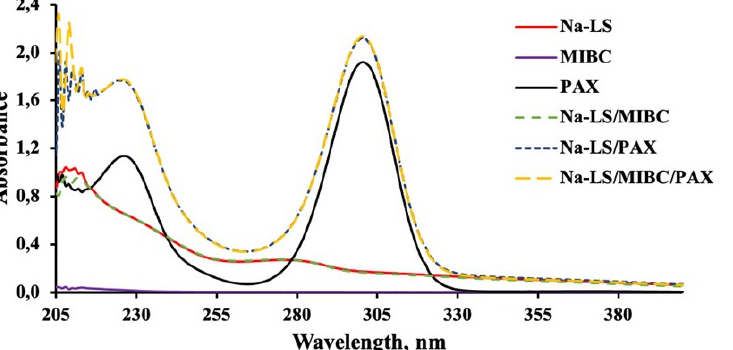
Figure 8. Absorbance spectra of Na-LS (50 ppm), PAX (25 ppm) and MIBC (15 ppm), used in flotation without contacting the mineral in (0.01 M NaCl).